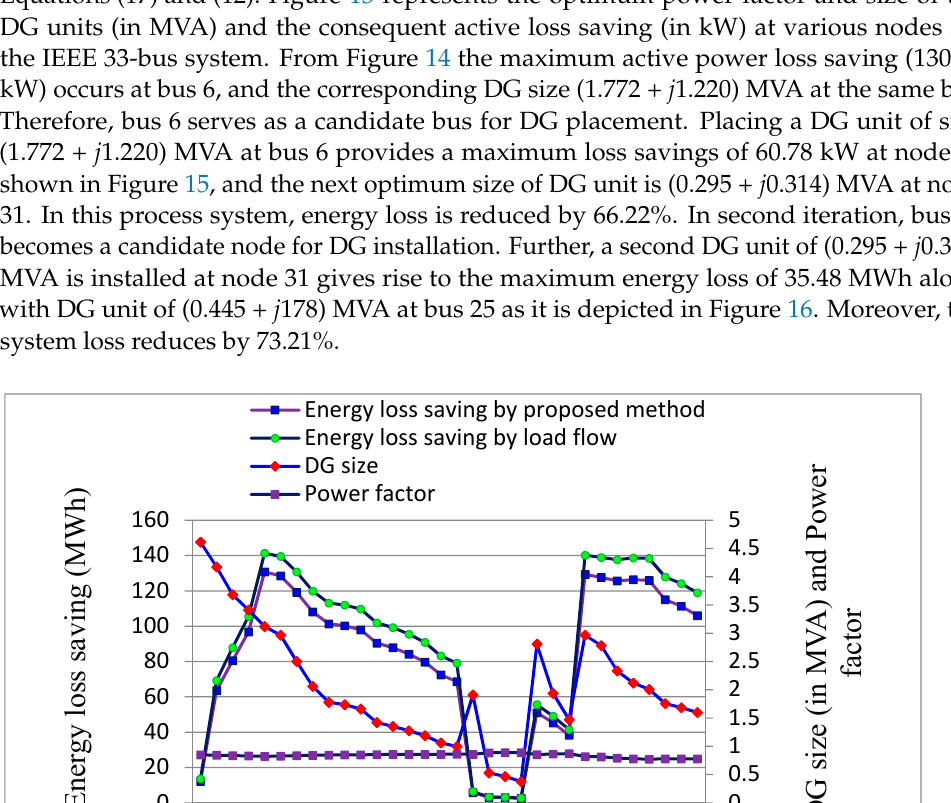
Figure 16. DG sizes (in MVA) with DG placed at nodes 6 and 31 and corresponding energy loss saving (in MWh).